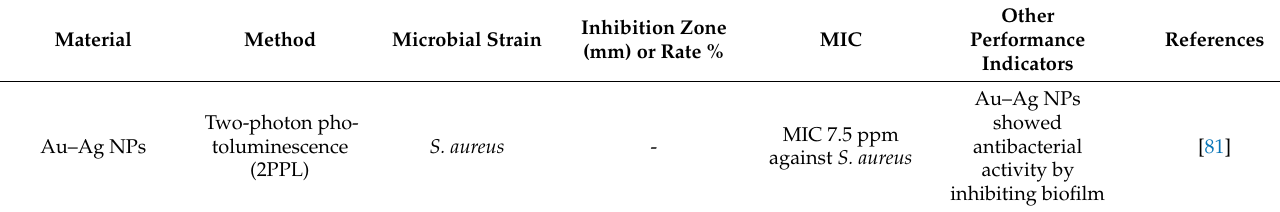
Table 1. Antimicrobial action of bimetallic Au–Ag